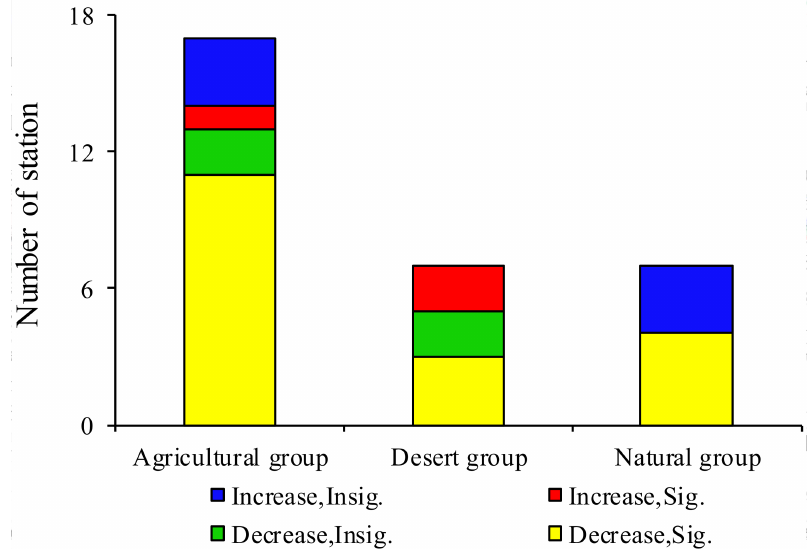
Figure 5. Percentage of stations with different annual ET0